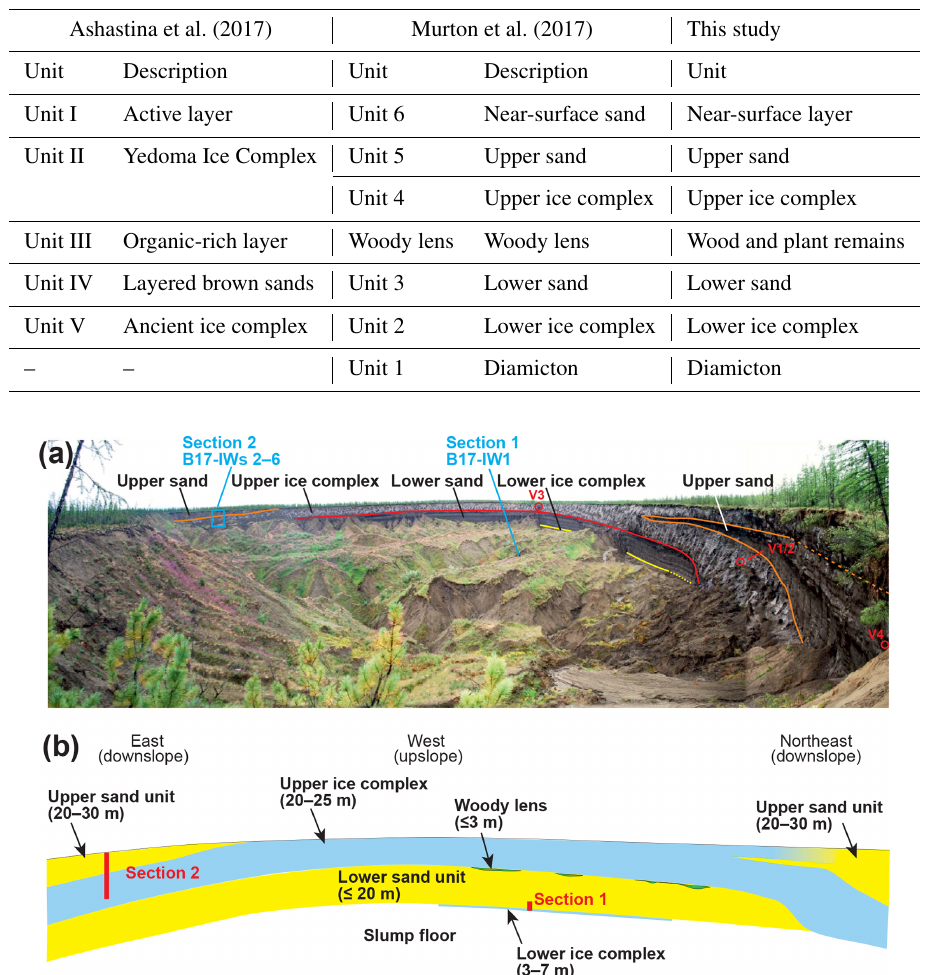
Figure 3. (a) Panoramic photograph of the Batagay megaslump with main stratigraphic units and approximate sampling locations of ice wedges (blue arrows). Red circles and numbers indicate the approximate sampling locations of ice wedges used by Vasil’chuk et al. (2017). (b) Schematic stratigraphic section of the exposed units along the headwall of the Batagay megaslump with approximate positions of the studied